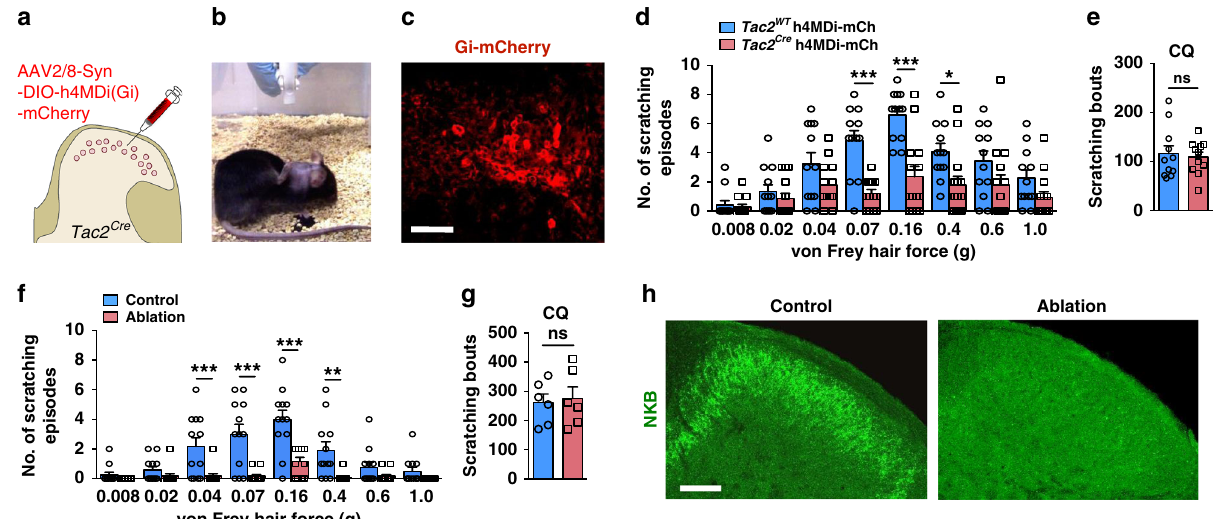
Fig. 4 Inhibition of Tac2 neurons in the spinal cord attenuated mechanical itch. a Schematic of intraspinal injection. b A snapshot of mouse with scratching behavior induced by von Frey fi lament. c IHC image of mCherry + neurons (red) in the cervical spinal cord of Tac2 Cre mice injected with hM4Di- mCherry virus. All 14 mice with virus injections were subjected to IHC con fi rmation. Scale bar, 50 μ m. d , e Mechanical itch test ( d ) and CQ itch test ( e ) after chemogenetic inhibition of Tac2 Cre neurons. ( d two-way ANOVA with Bonferroni post - hoc , * p = 0.019, *** p = 0.0001, n = 12 mice for Tac2 WT and n = 14 mice for Tac2 Cre ; e unpaired two-tailed Student ’ s t- test, p = 0.72, n = 11 mice per group, ns not signi fi cant). f , g Mechanical itch test ( f ) and CQ itch test ( g ) after conditional ablation of Tac2 Cre neurons in the spinal cord. ( f two-way ANOVA with Bonferroni post - hoc , ** p = 0.002, *** p = 0.0001, n = 12 mice per group; g unpaired two-tailed Student ’ s t- test, p = 0.78, n = 6 mice per group, ns not signi fi cant). h IHC of NKB (green) in the cervical spinal cord of control mice (left) and mice with conditional ablation of Tac2 Cre neurons (right). Scale bar, 100 μ m. All data are presented as means ± s.e.m. and error bars represent s.e.m. Source data are provided as a Source Data fi